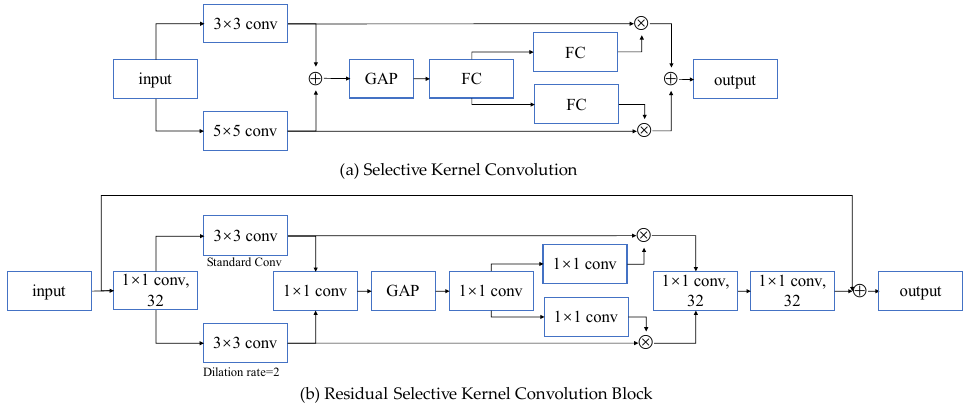
Figure 2. Residual selective kernel convolution structure.